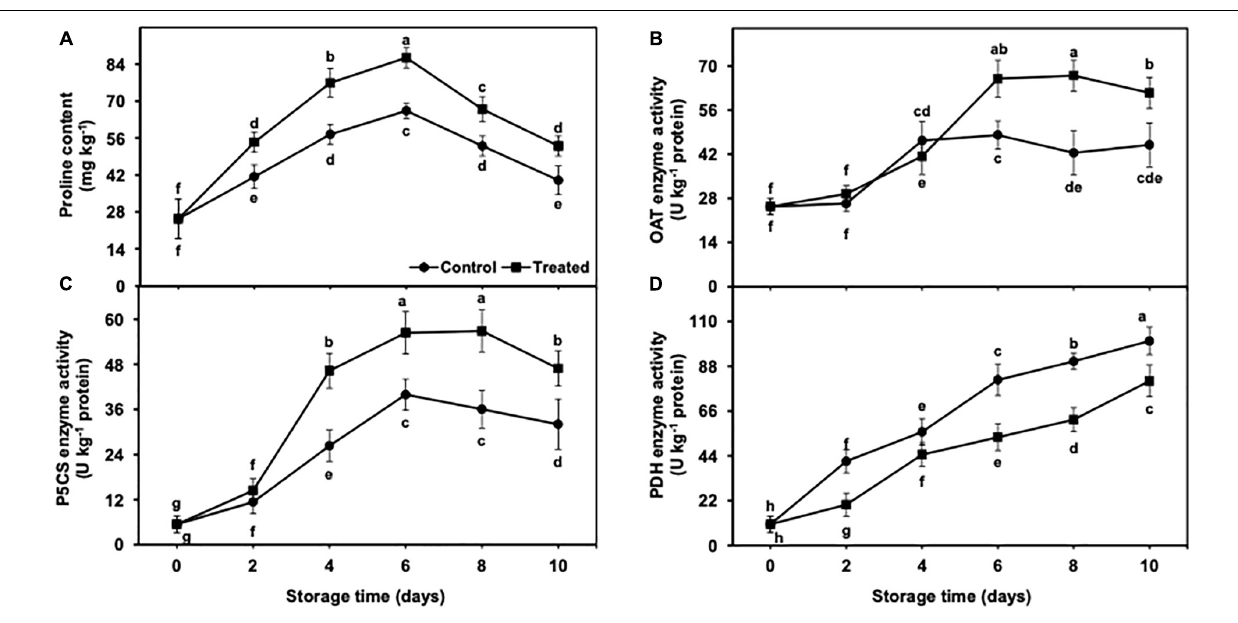
FIGURE 7 | Effect of hydrogen sulfide on proline content (A) , OAT (B) , P5CS (C) and PDH (D) enzymes activity in peel of banana fruit. Data are mean of three replications and vertical bars show standard of the means. Different letters show significant difference according to least significant difference